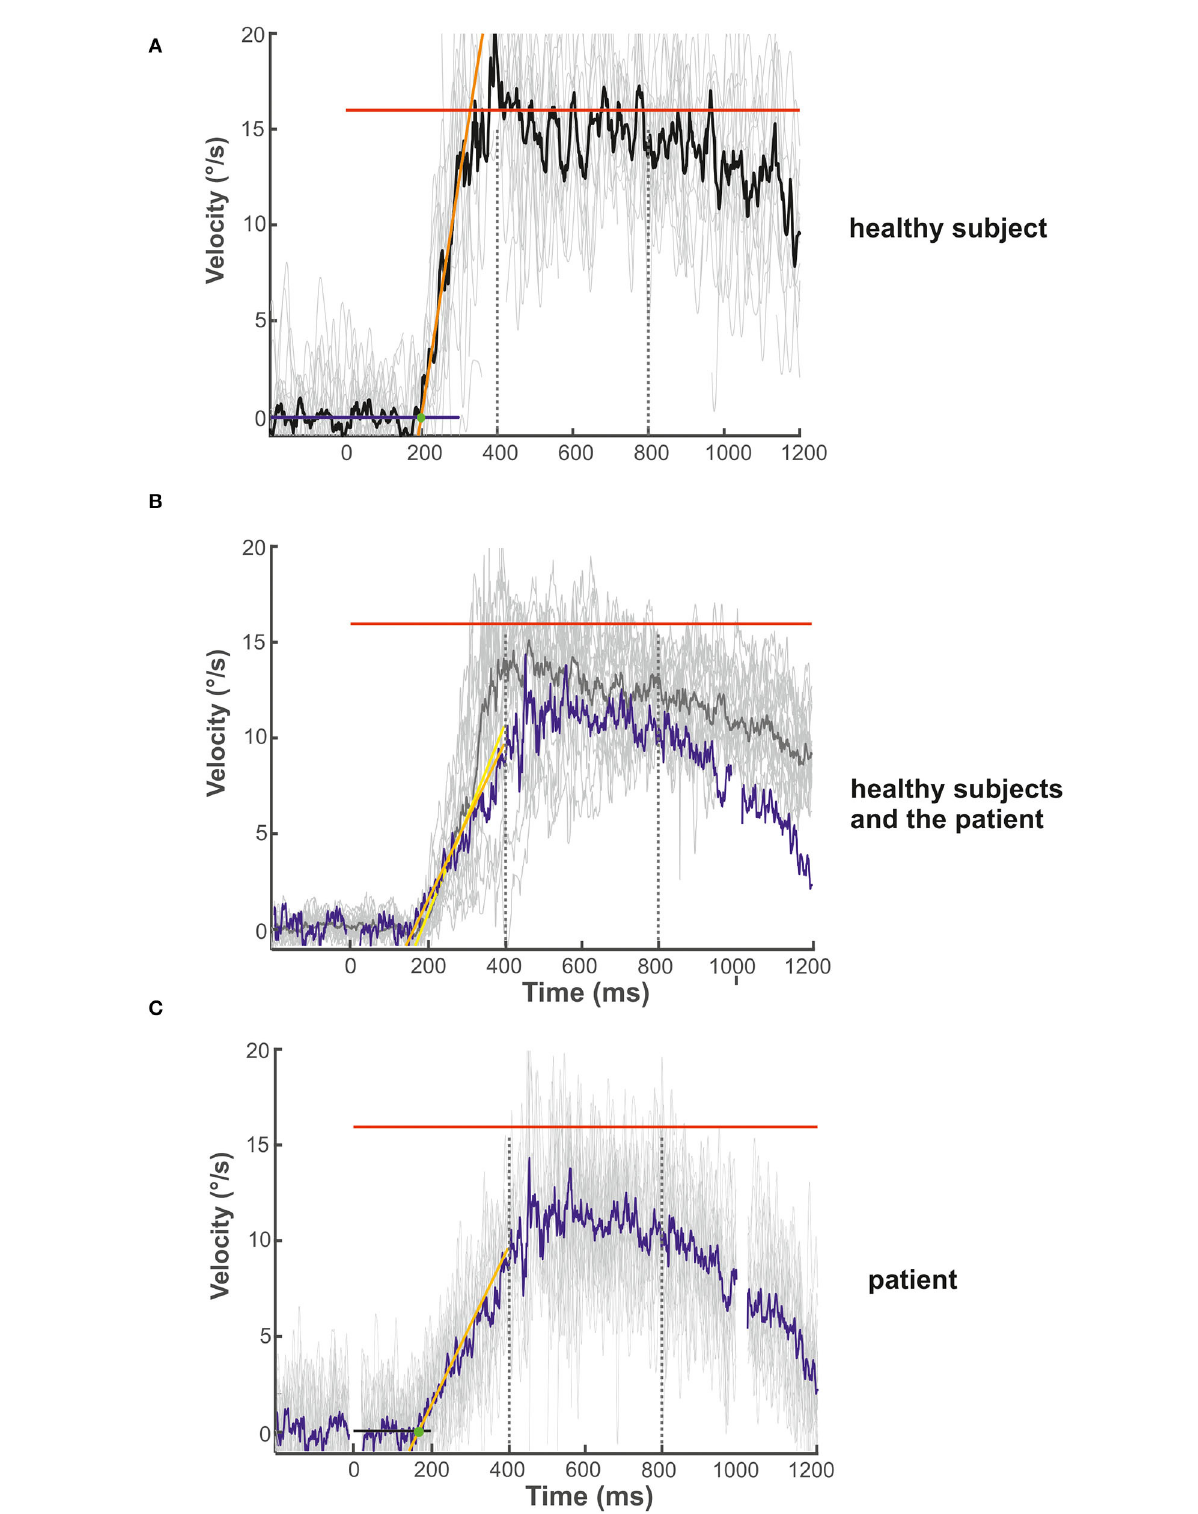
FIGURE3 Examples of the initial and maintenance pursuit velocity in a healthy control subject [ (A) : gain: 0.89, latency: 199ms, acc.: 123.35 ◦ /s ² ] and the patient [ (C) : gain: 0.69, latency: 192ms, acc.: 35.94 ◦ /s ² ] responding to the step-ramp stimulus paradigm. For each subject, the bold trace shows the median of all individual (thin gray lines) ramp velocities. Figure (B) shows the mean (thick gray trace) of the individual median eye velocity of